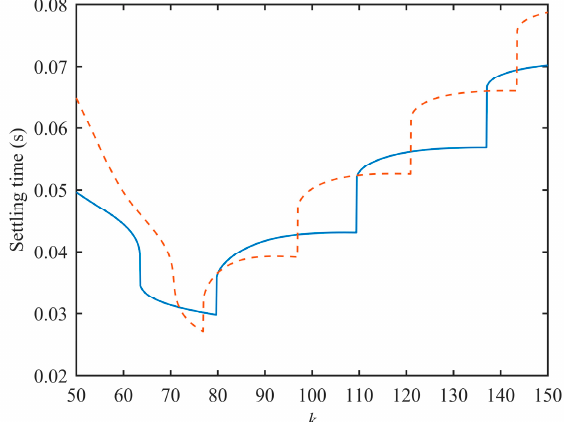
Figure 15. 2% settling time of the proposed PLL (with dc rejection capability) under phase and frequency jump.